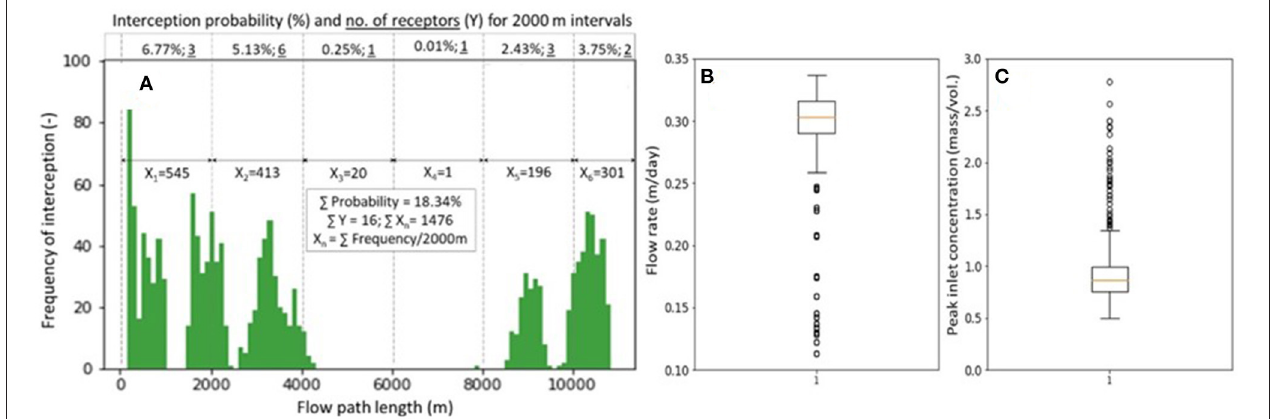
FIGURE 8 | (A) Distribution of particle tracks that intercepted groundwater-dependent assets and probability of interception for 2000m intervals; (B) Distribution of average groundwater flow rates along flow paths; (C) Distribution of solute inlet concentration into aquifer.